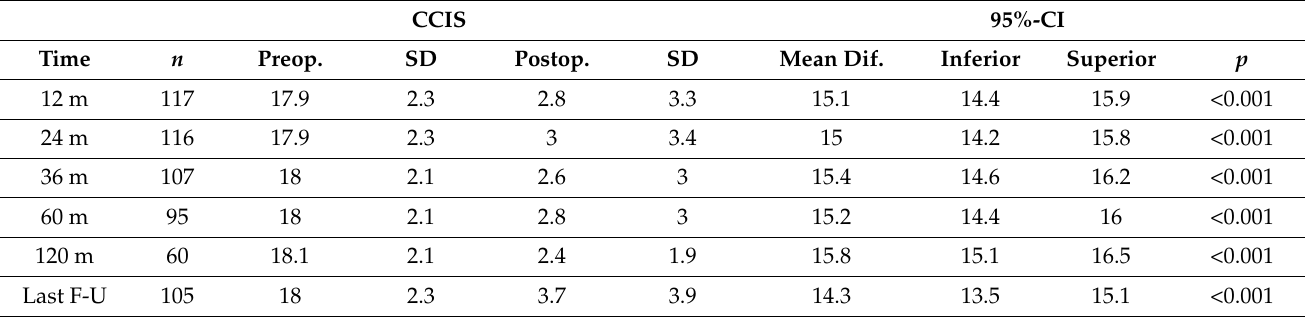
Table 2. Comparison of preoperative values of CCIS with that of the different postoperative periods. CCIS 95%-CI